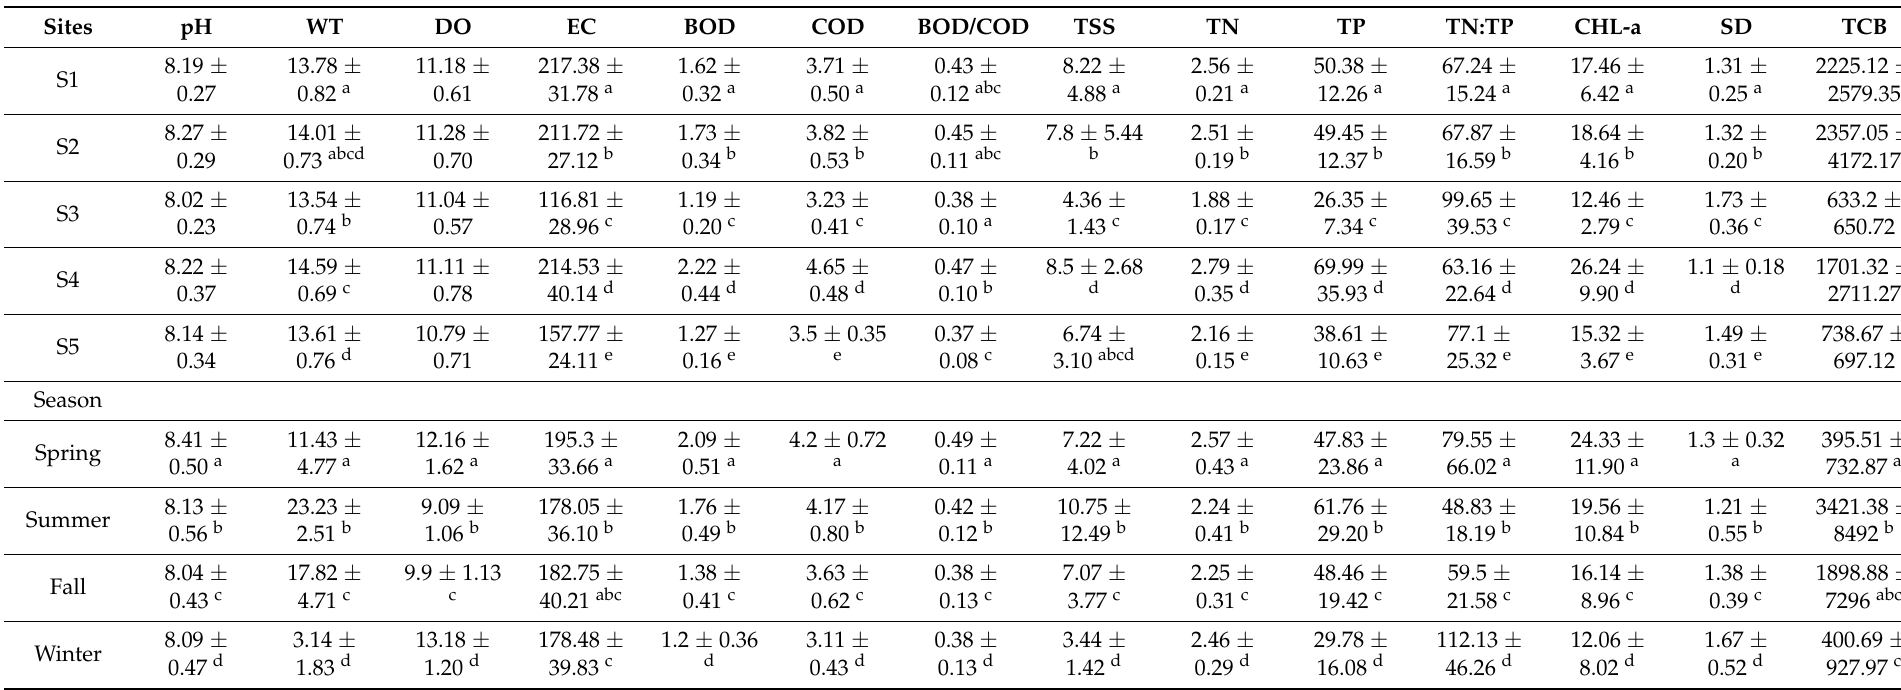
Table 1. Mean value of water quality parameters at different sites and seasons (units mg L − 1 , except pH, WT ( ◦ C), EC ( µ S cm − 1 ), TP ( µ gL − 1 ), CHL-a ( µ g L − 1 ), SD (m), and